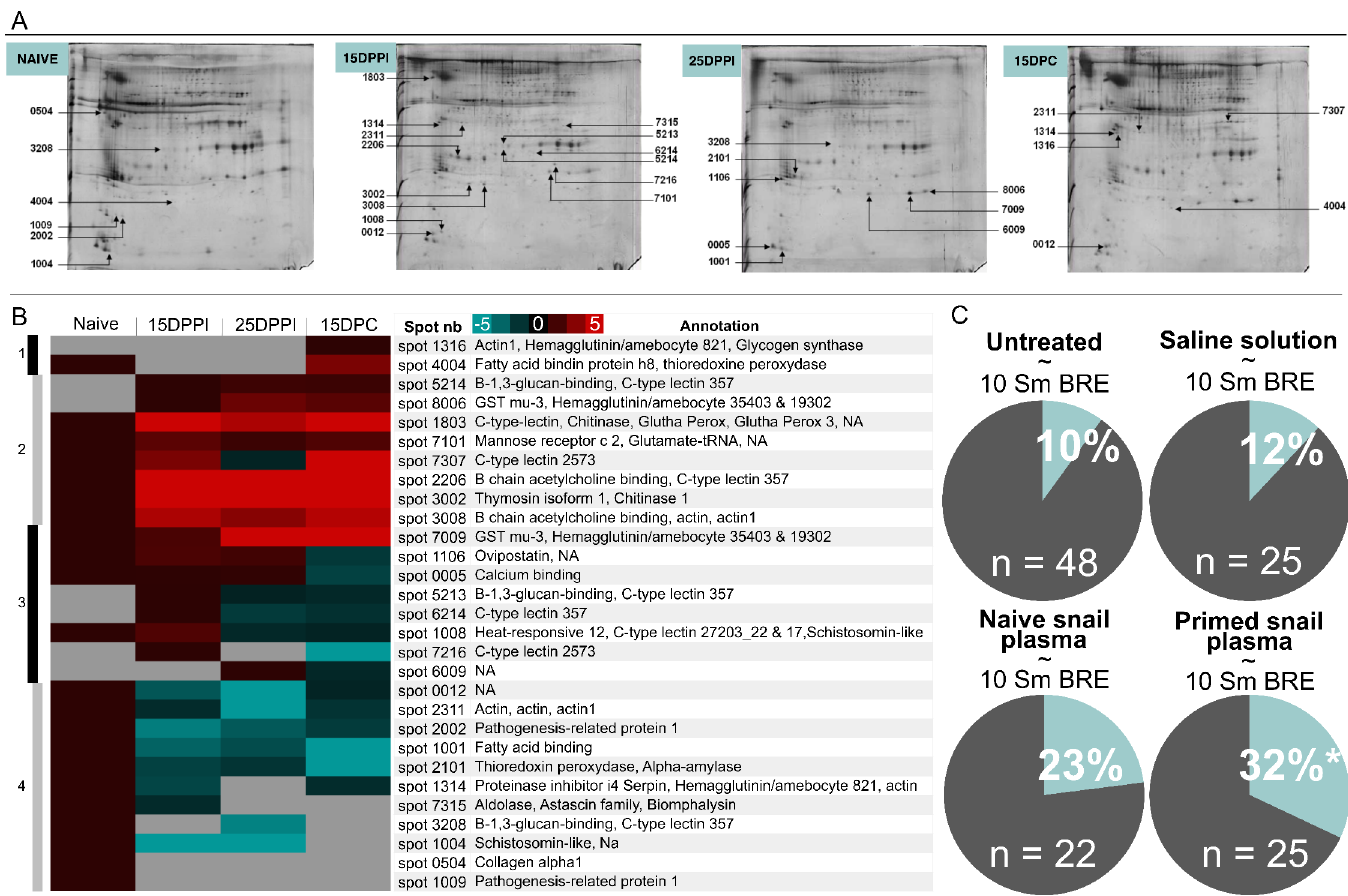
Fig 5. Role of B . glabrata plasmatic factors in innate immune memory response. A. 2D gel electrophoresis of plasma proteins. One gel of each plasma sample analysed was shown. Spot numbers of qualitative and quantitative differences were indicated. Four plasma samples were analysed from na ï ve (uninfected snails), 15DPPI and 25DPPI (recovered at 15 and 25 days after primo-infection) and 15DPC (recovered at 15 days after secondary challenge). B. Heat-Map of the qualitative and quantitative ratio versus na ï ve sample. Ratios were calculated using PDQuest software between all differentially regulated spots. Blue to red scale indicate ratio values from lower to higher represented spots. Four clusters are identified: Cluster 1: higher-represented proteins exclusively following secondary challenge (15 DPC). Cluster 2: sustained response: higher-represented proteins after the primo-infection and secondary infection. Cluster 3: higher-represented proteins at 15DPPI and thereafter down regulated at 25DPPI and 15DPC. Cluster 4: lower-represented proteins. C. Plasma transfer and effect on prevalence of S . mansoni infection. Four conditions were tested: untreated snails (Control group, n = 48); saline injected snails (control of injection, n = 25); na ï ve-plasma injected snails (n = 22); and primed-plasma injected snails (n = 25). For all the experimental groups, 15 days following injection, snails were infected with 10 miracidia of SmBRE. * indicated significant differences (P < 0.05).